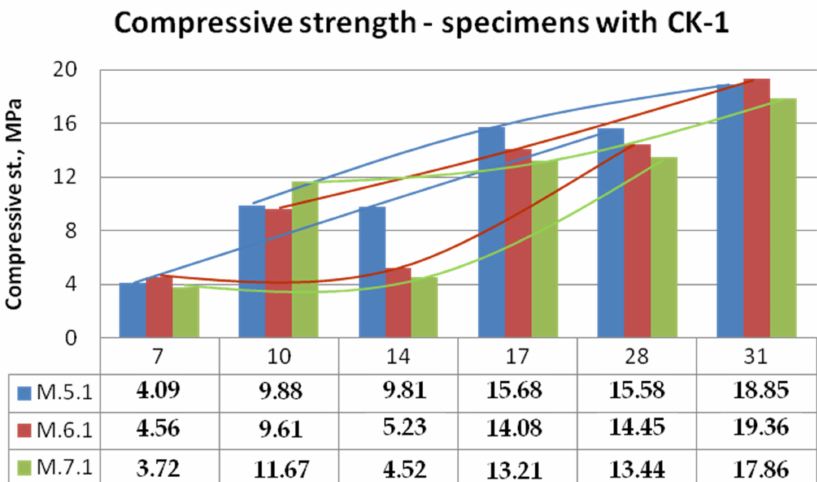
Figure 17. Compressive strength of mortars with calcined kaolin